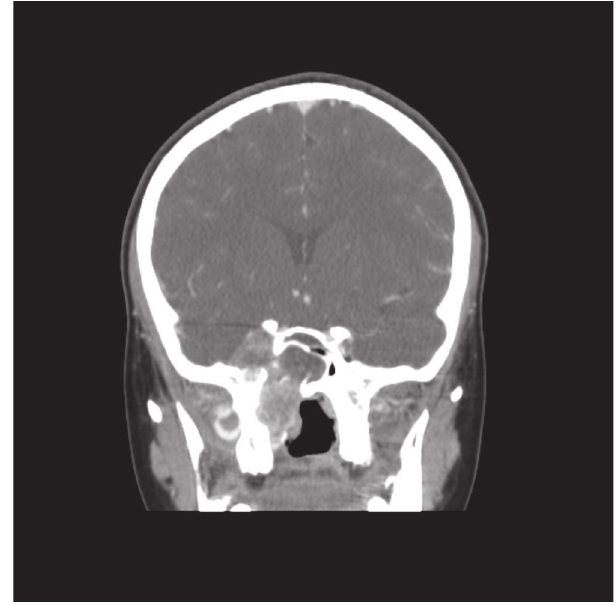
Figure 4 Postoperative computed tomography scan showing the extent of resection and a tumor recurrence.